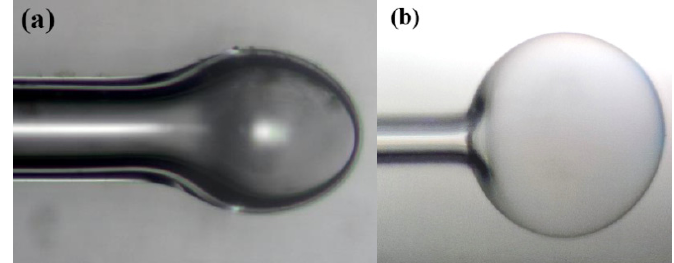
Figure 2. Fabricated microbubbles: ( a ) egg-shaped microbubble; and ( b ) spherical micobubble.